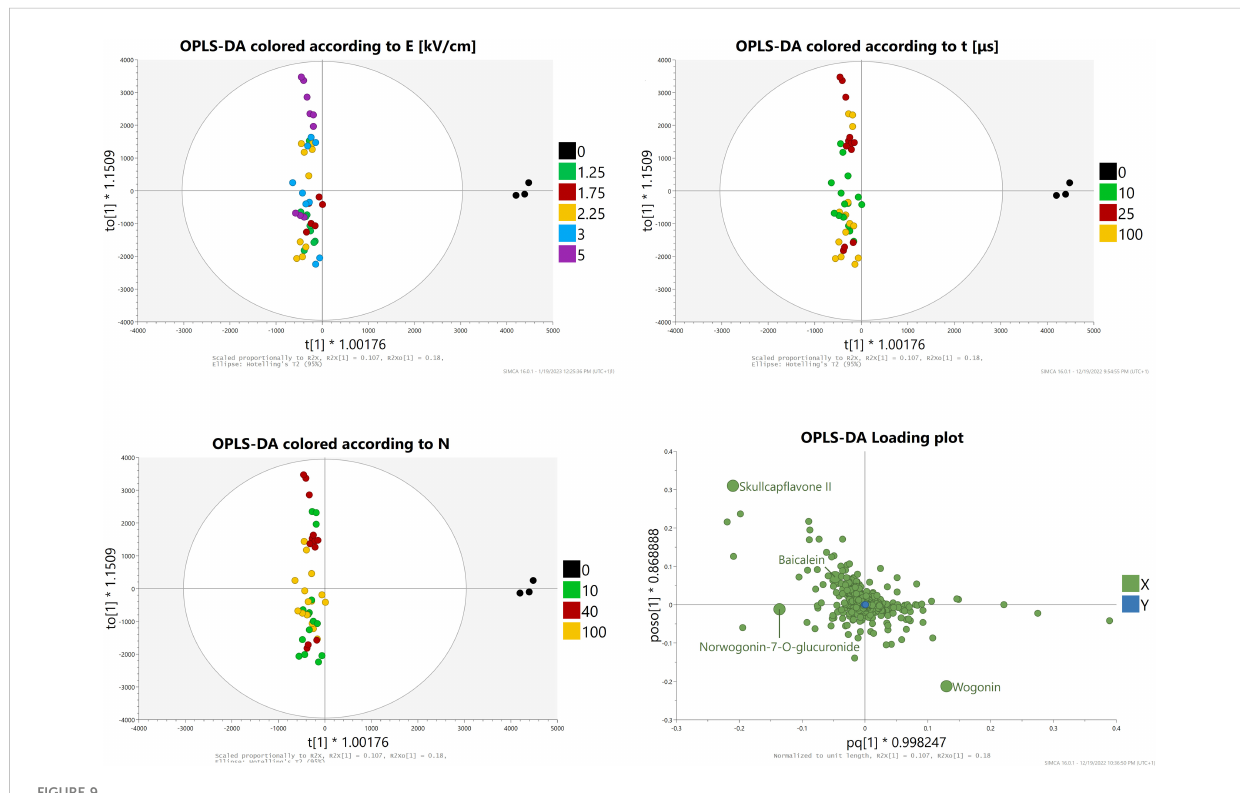
FIGURE 9 OPLS-DA analysis Score and loading